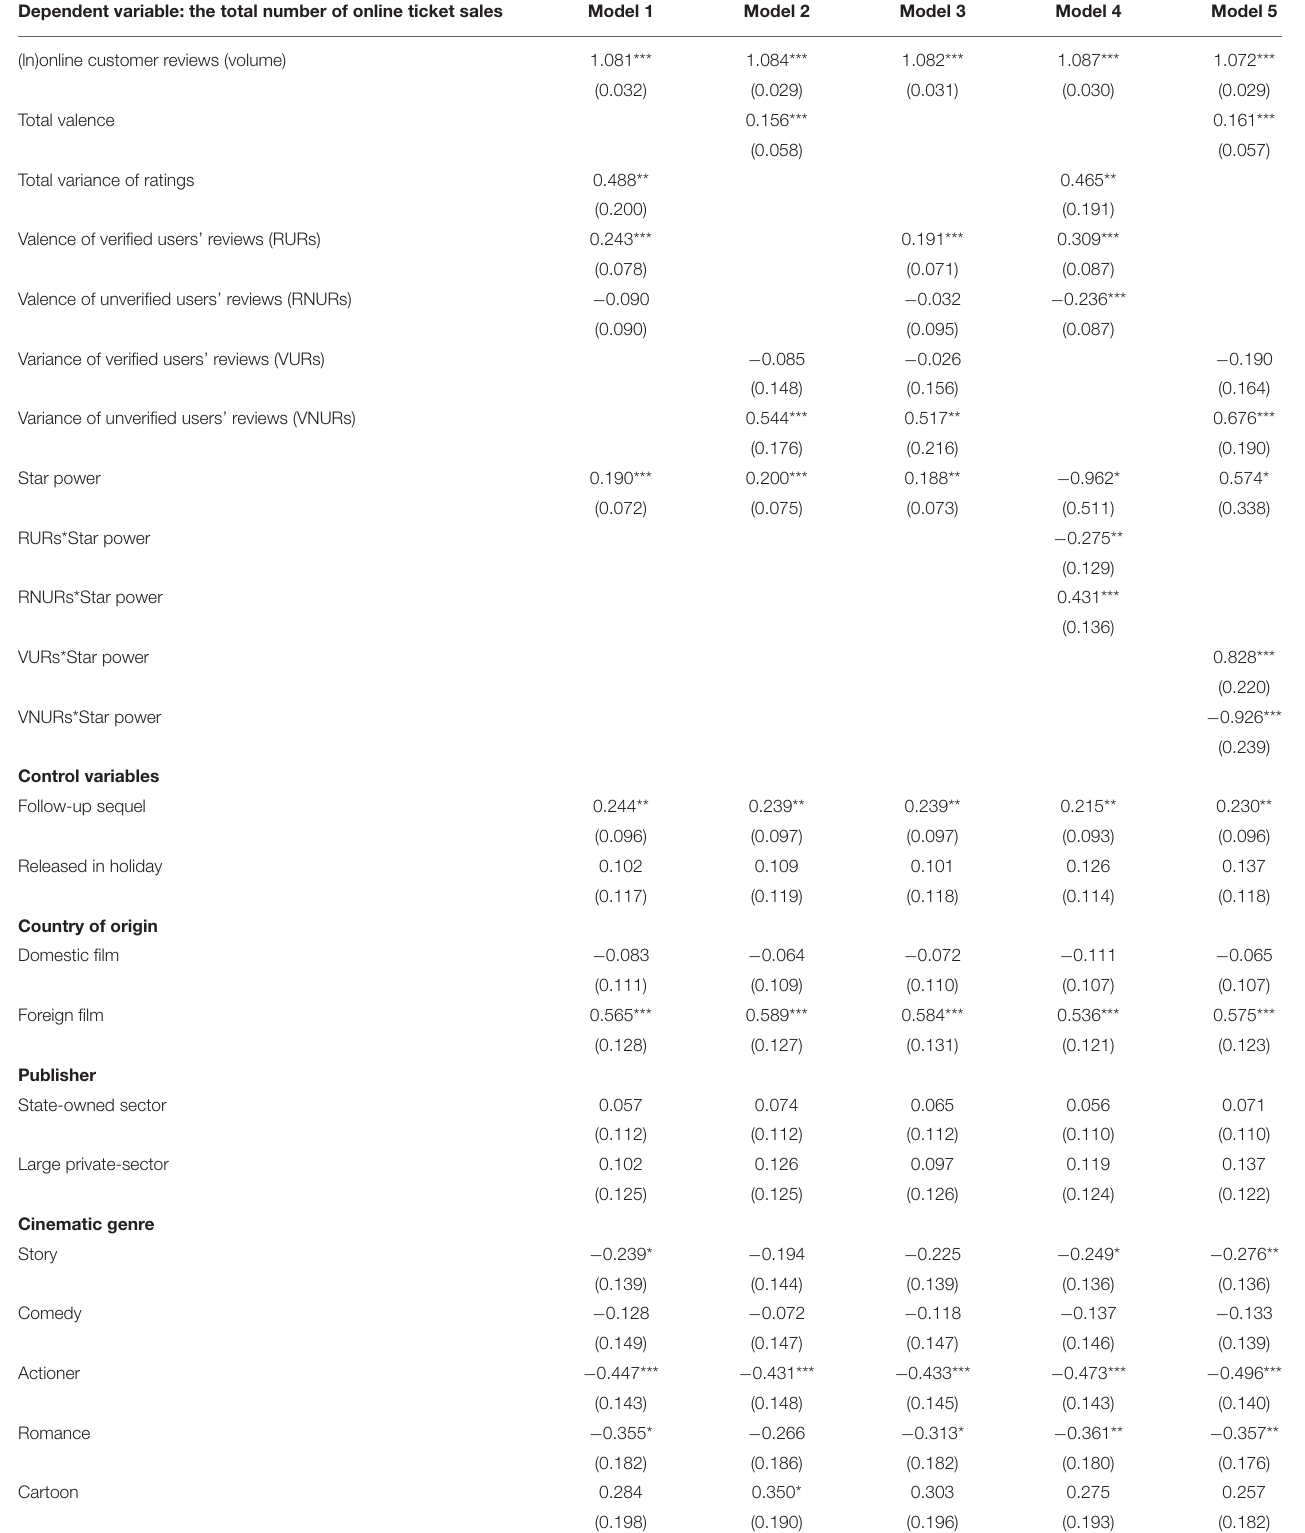
TABLE 2 | Results of regressions testing for direct and moderation